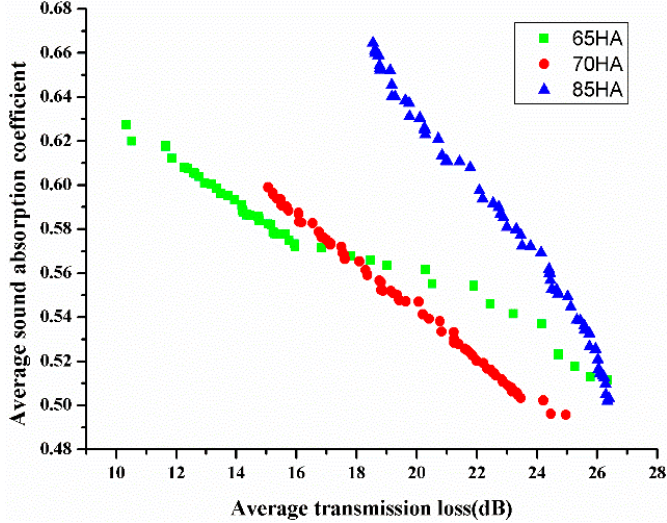
Figure 1. Pareto solutions of Response Surface (RS) model.